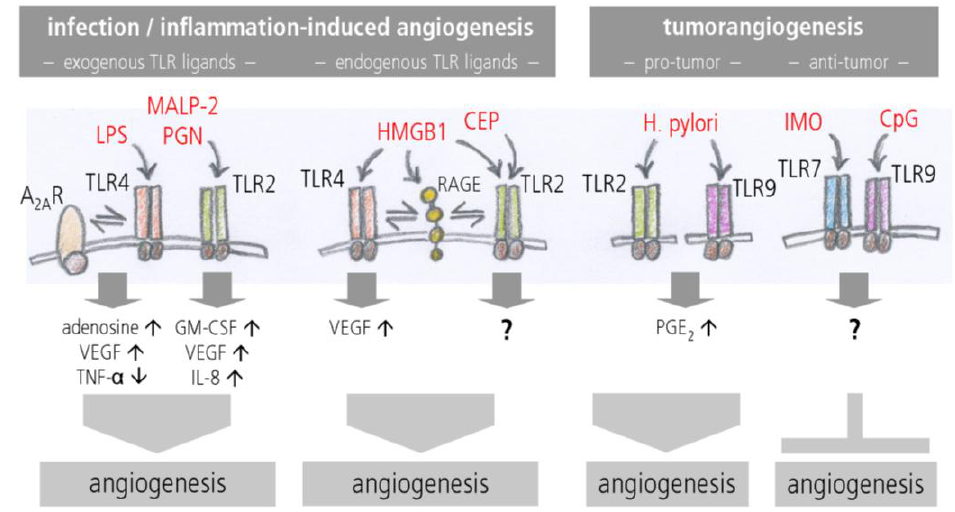
FIGURE 4. Current understanding of the involvement of TLRs in